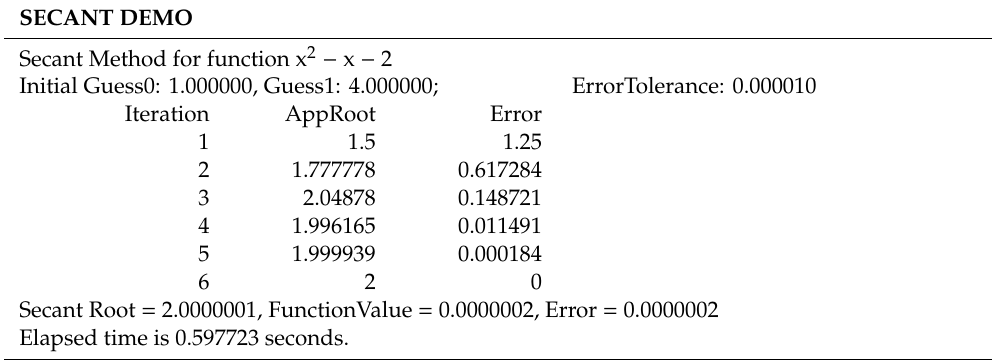
Table 7. Secant algorithm, iterations, AppRoot and